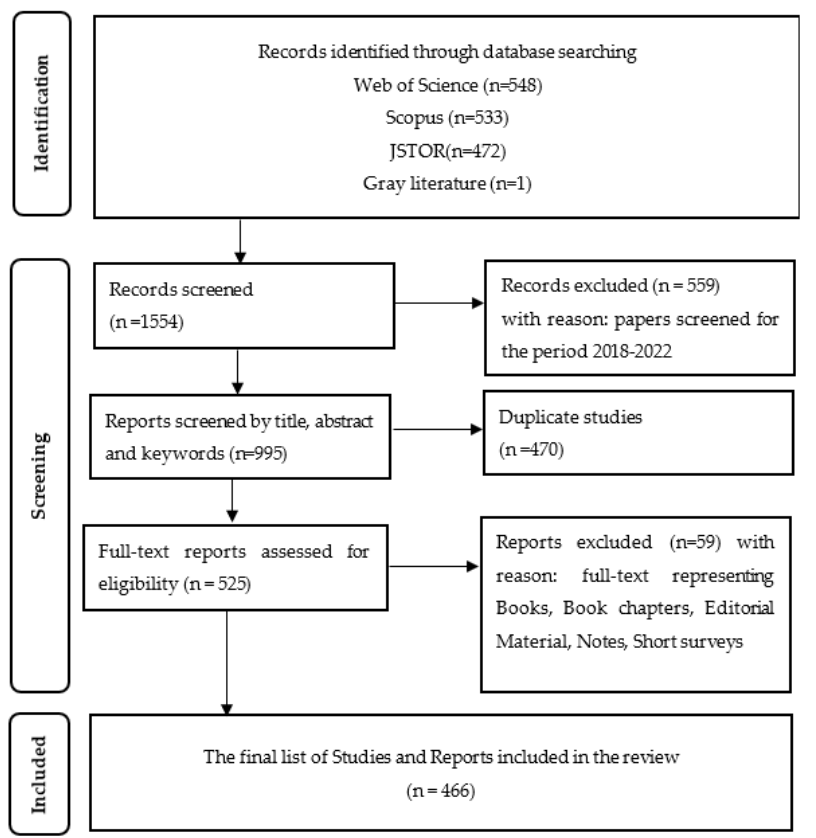
Figure 2. PRISMA flowchart of literature review process based on the combined search of two keywords: social innovation and circular*.